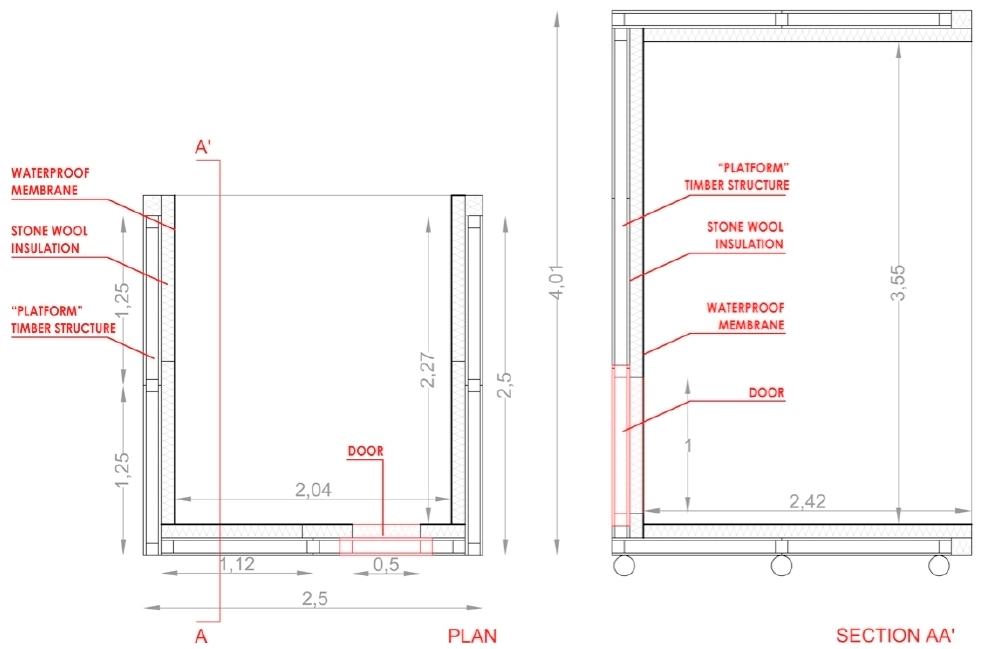
Figure 3. Drawing of the metering box (horizontal plan and vertical section). Measurements expressed in meters.